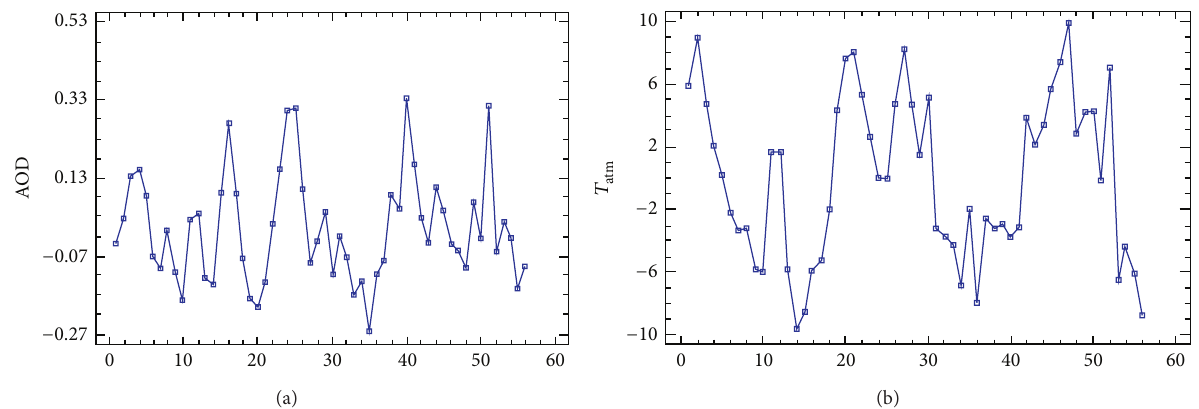
Figure 5: Time series for (a) aerosol optical depth measurements generated using MODIS data and (b) atmospheric temperature at 908 hPa generated using TES data.